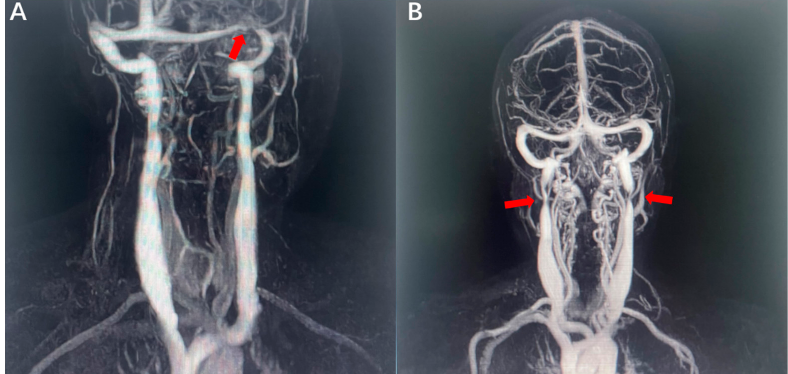
Figure 1. Representatives of CE-MRV findings in patients with IJVS and CVSS. ( A ) The initial CE- MRV showed severe CVSS (Red arrow), which was surrounded by abnormally distorted vertebral venous plexuses. ( B ) The initial CE-MRV showed IJVS (Red arrow) with abnormal distorted cortical and vertebral venous